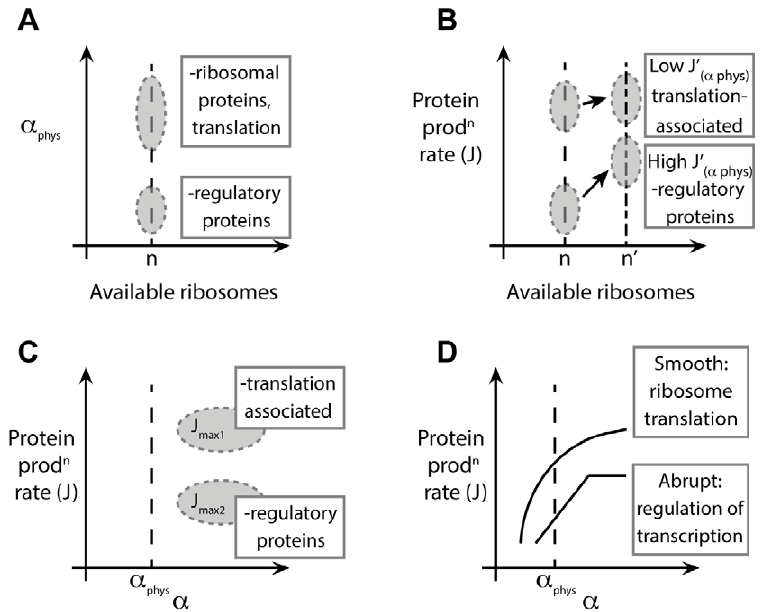
Figure 8. Initiation rate: summary of the findings. ( A ) For a given ‘physiological’ number of ribosomes n we found mRNA-specific initiation rates, distributed over a broad range of values (Figure 2). Different regions of the distributions can be mapped to certain GO annotations. For example, mRNAs with small physiological initiation rate a Q are regulatory proteins while genes involved in translation have a larger initiation rate. ( B ) Changes in initiation (induced, for instance, by variations in the ribosomal pool, e.g. available ribosomes increase to a value of n ’ ) are estimated by our modelling and theoretically perceived by the transcript in different ways, according to their current-initiation relationship J ( a ) . In particular, some mRNAs have a large gearing factor J ’ ( a Q ) , such as regulatory proteins, while other messengers, such as translation associated ones, are less sensitive to changes of the initiation rate. ( C ) For very large initiation rates the protein production rates reach a maximal elongation-limited value, i.e. only depending on the sequence of codons. We discover that translation associated genes have a larger maximal production rate when compared to other mRNAs, such as regulatory proteins, whose production might need to be capped. ( D ) In general we find two main groups of sequences classified according to their current-initiation relationship J ( a ) . Abrupt sequences, usually regulatory proteins, present an abrupt ‘kink’ in J ( a ) , meaning that the protein production rate can quickly saturate above specific values (sequence-dependent) of the initiation rate. Genes involved in translation like ribosomal proteins are instead classified as smooth sequences, since their sequences are such that this abrupt crossover does not